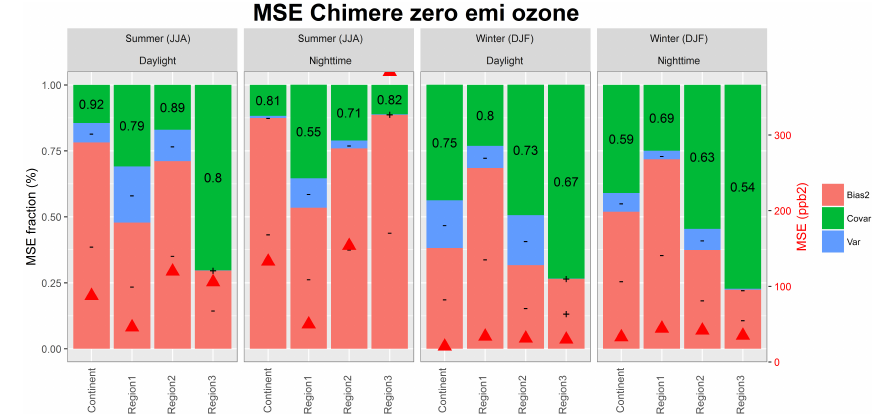
Figure 13. As in Fig. 11 for the hourly time series of “zeroed anthropogenic emissions”